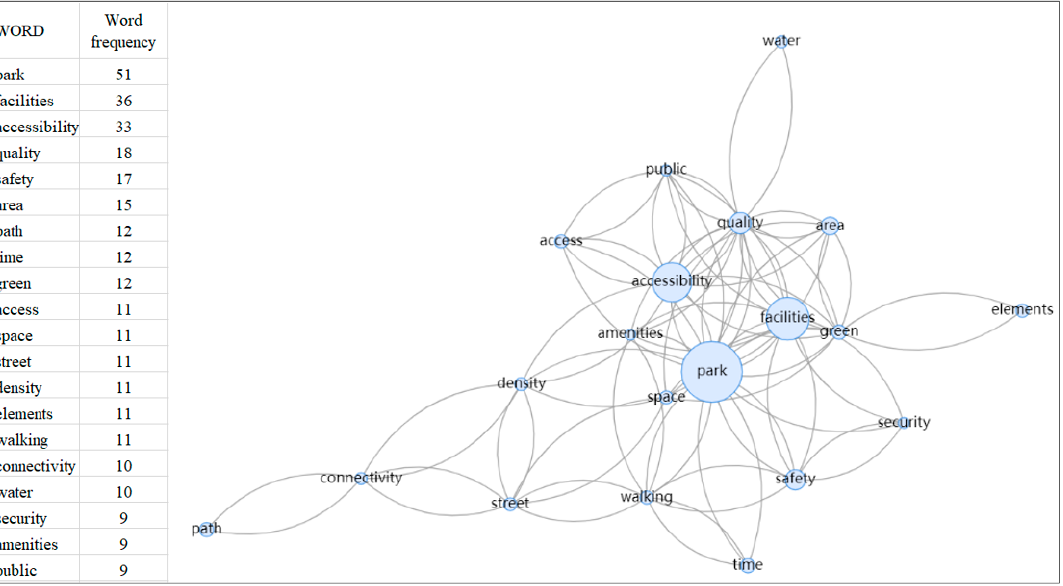
Figure 5. Relationship analysis of the top 20 words of all indicators.